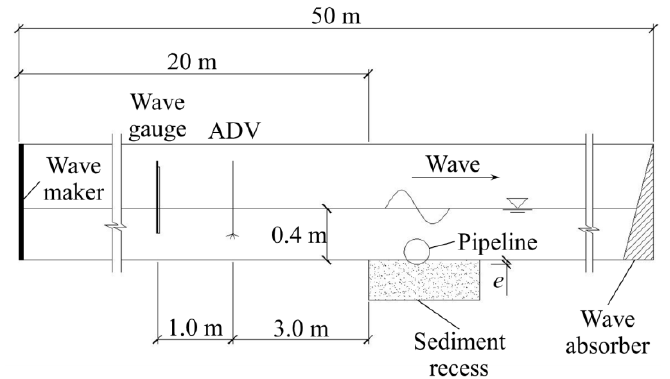
Figure 2. Sketch of the test flume (not to scale).